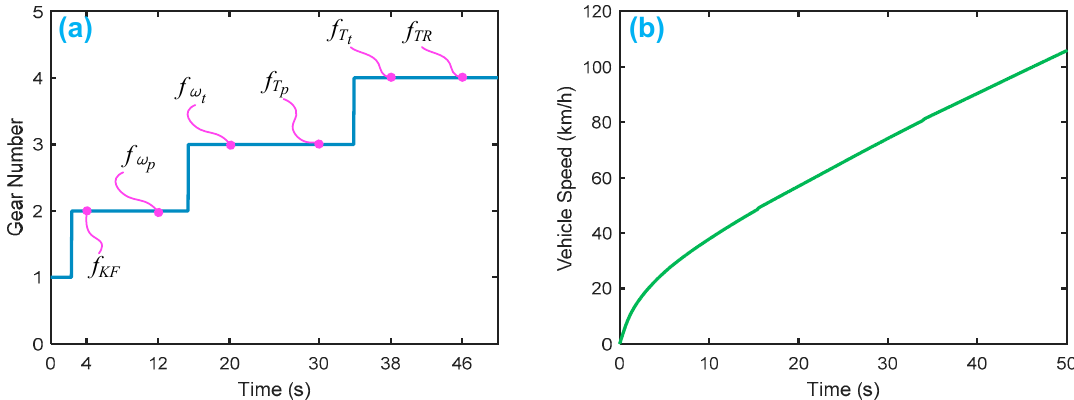
Figure 10. Normal driving simulation of a vehicle with an HTC in a four-speed transmission: ( a ) gear shifting in a driving cycle; ( b ) vehicle speed in a driving cycle. Here, we only show gradual acceleration without braking.